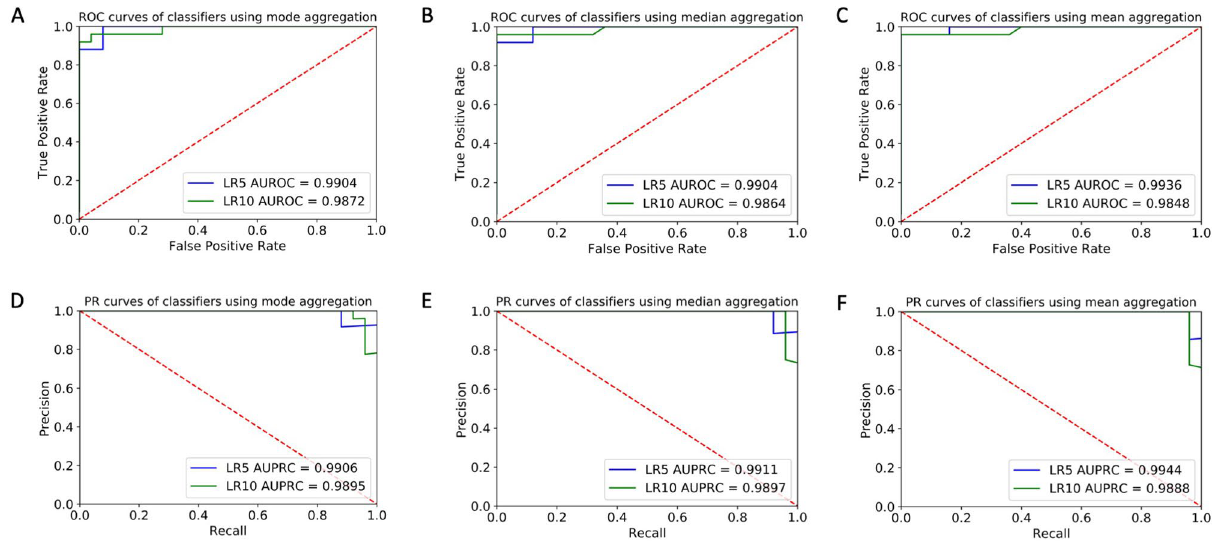
Figure 2. Receiver Operating Characteristic (ROC) and Precision-Recall (PR) curves of the classifiers trained on aggregated features from the filtered crowd raters. The blue line shows the performance of the LR5 classifier and the green line shows the performance of the LR10 classifier. ROC curves for input features to the classifier are aggregated using the ( A ) mode, ( B ) round of the mean, and ( C ) median of the crowd worker responses. The true positive rate is plotted against the false positive rate for different class cutoffs of the logistic regression classifier’s output probability. PR curves for input features to the classifier are aggregated using the ( D ) mode, ( E ) round of the mean, and ( F ) median of the crowd worker responses. Precision is plotted against recall for different class cutoffs of the logistic regression classifier’s output probability. For both ROC and PR curves, area under the curves increasingly closer to 1.0 indicate increasingly better performance, and a value of 0.5 indicates random guessing by the